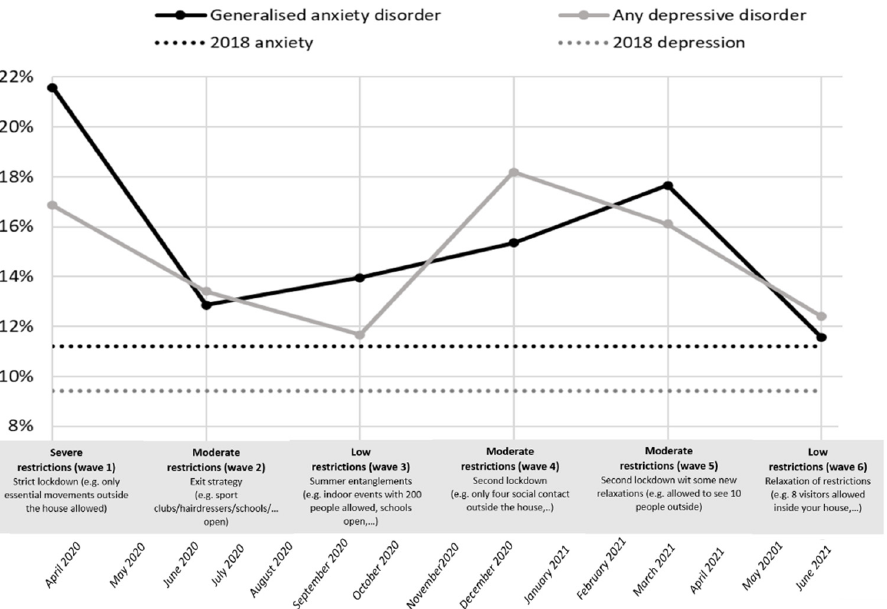
Figure 1. Evolution of anxiety disorder and depressive disorder during COVID-19 times (6 different time points)—weighted proportions (reference line: indication anxiety and depression, HIS 2018). Table 2. Descriptive analysis of the longitudinal data: people who participated in all 6 waves (crude %).